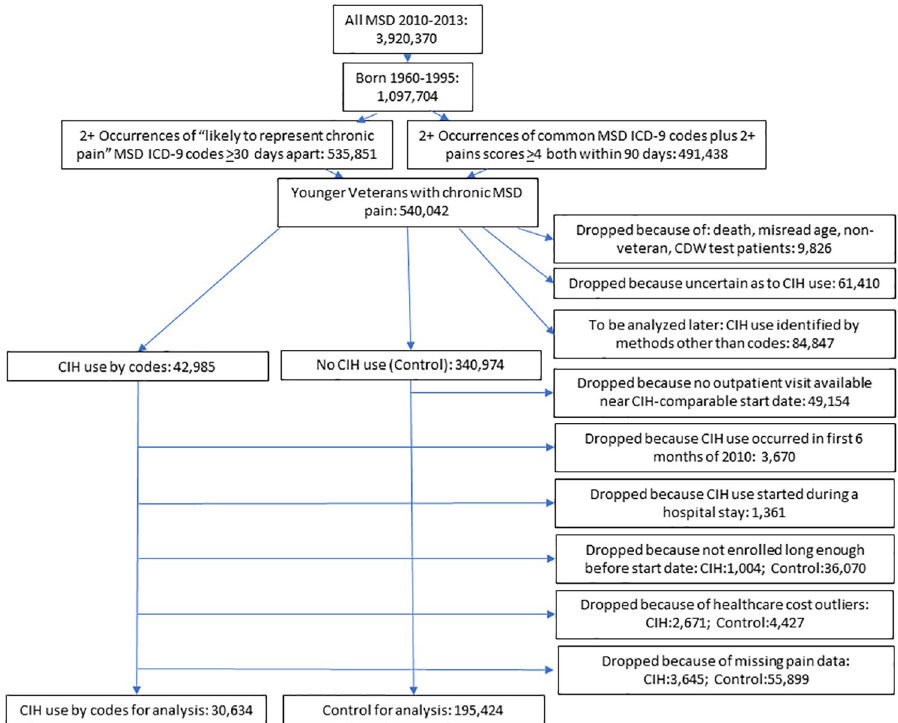
Fig 1. Veteran flow into the analytic cohort. CDW = Corporate Data Warehouse (repository for US Veterans Health Administration data); CIH = complementary and integrative health approaches/therapies; MSD = musculoskeletal